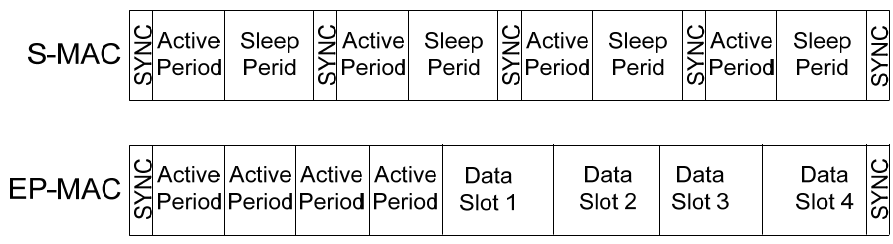
Figure 3. Comparison of Frame structure of EP-MAC with S-MAC.